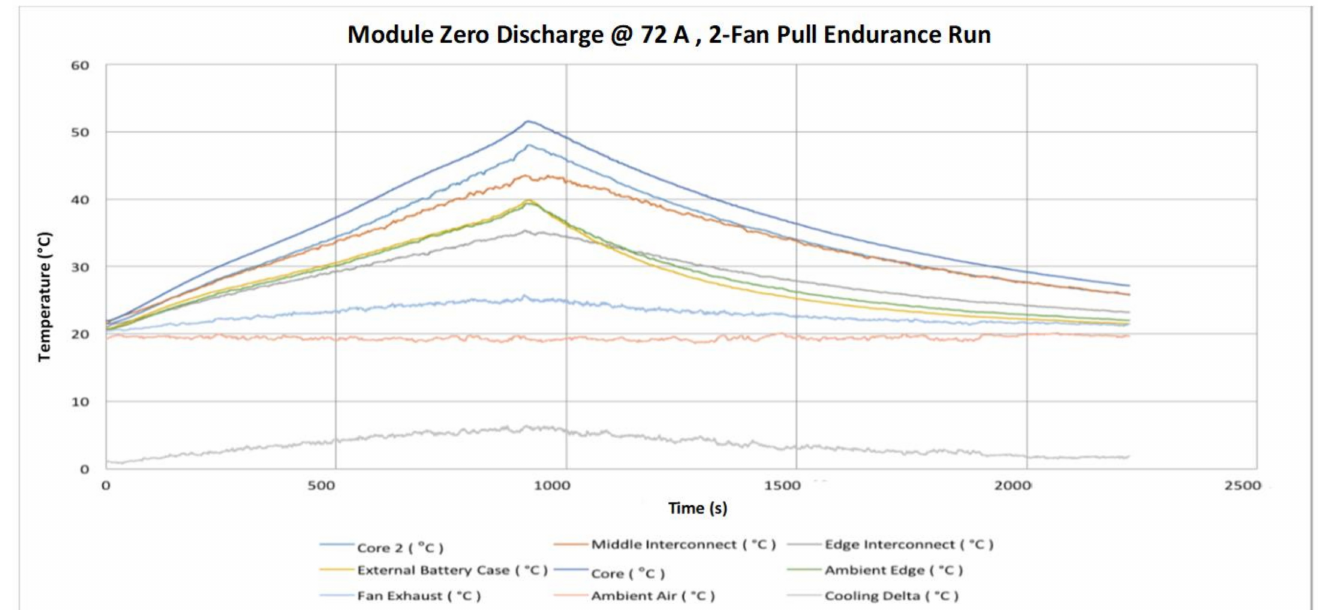
Figure 21. Module zero discharge, 72 A 2-fan pull cooling.